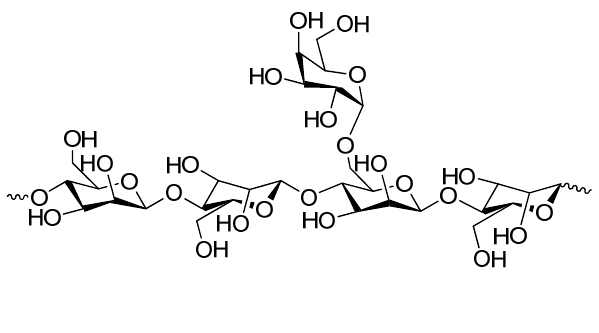
Figure 8. Chemical structure of locust bean